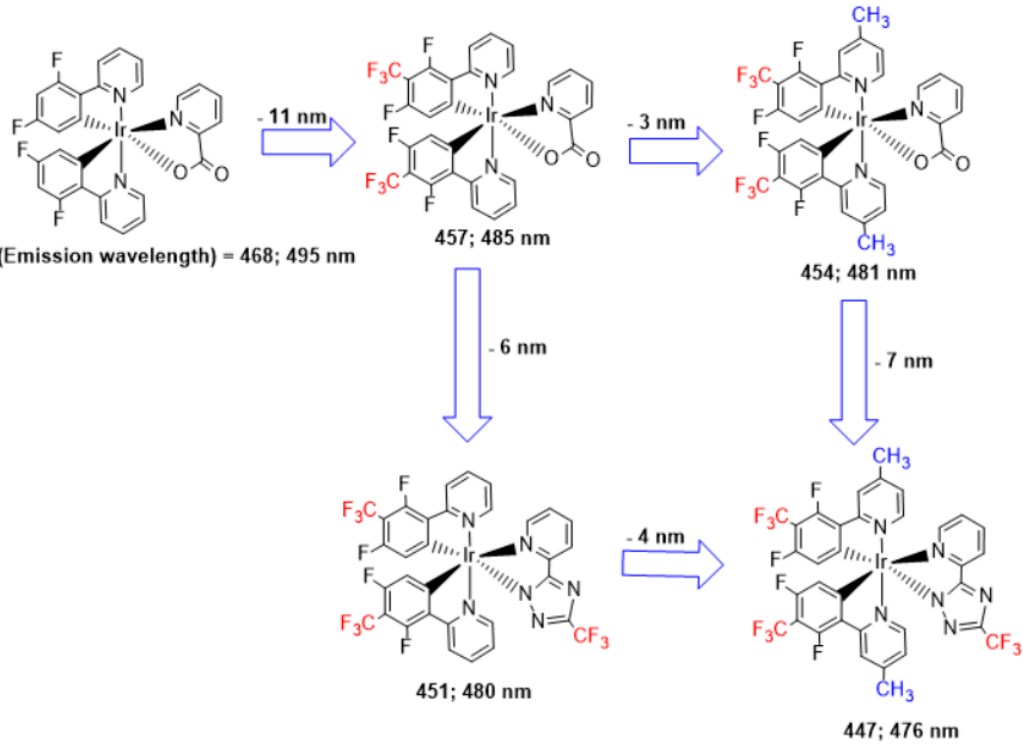
Figure 2. Structures of triazole derivatized cyclometalated Ir(III) complexes [52], [Adapted with permission from (Takizawa et al.). Copyright (2006), Chemical Society of Japan].